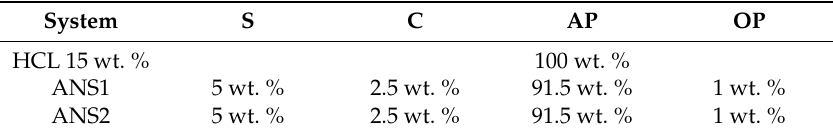
Table 2. Acid nanoemulsion systems composition.